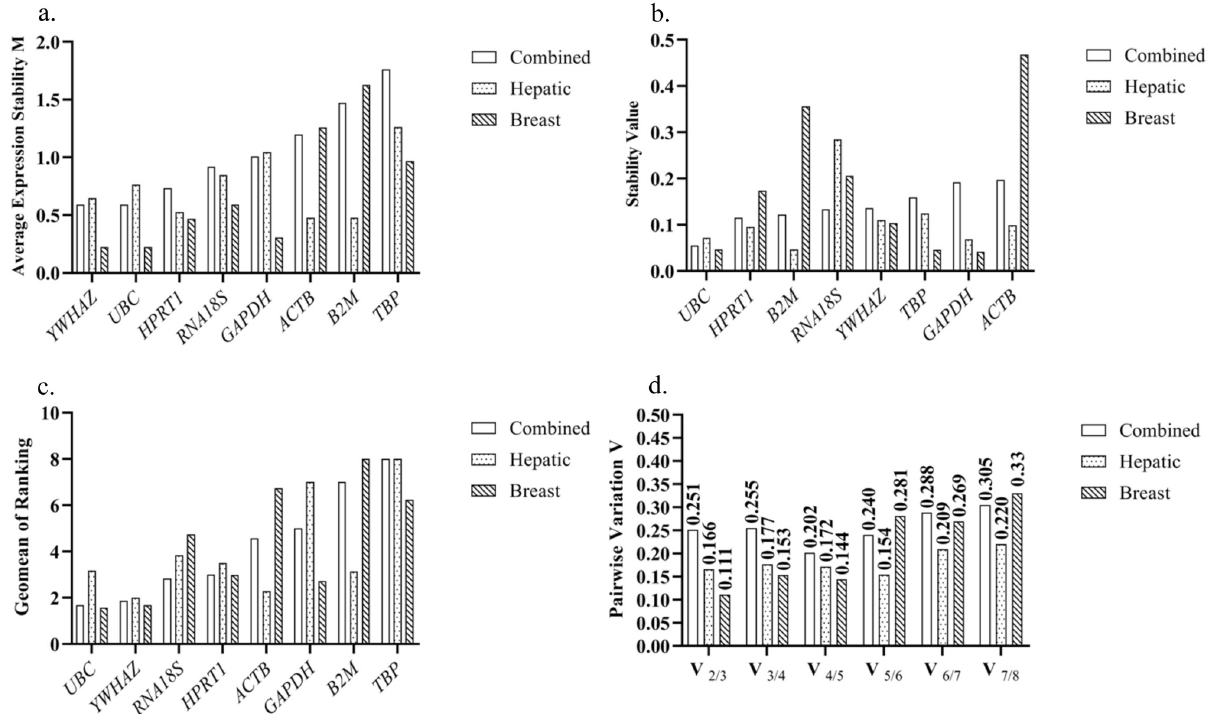
Fig 2. Stability ranking orders of the studied reference genes resulted from A. geNorm, B. NormFinder, and C. RefFinder algorithms in the combined sample besides the hepatic and breast cancer cell lines separately. D. Indication of the optimum number of reference genes in the combined sample besides the breast and hepatic cancer cell lines separately via geNorm algorithm. The combined sample refers to hepatic and breast cancer cells